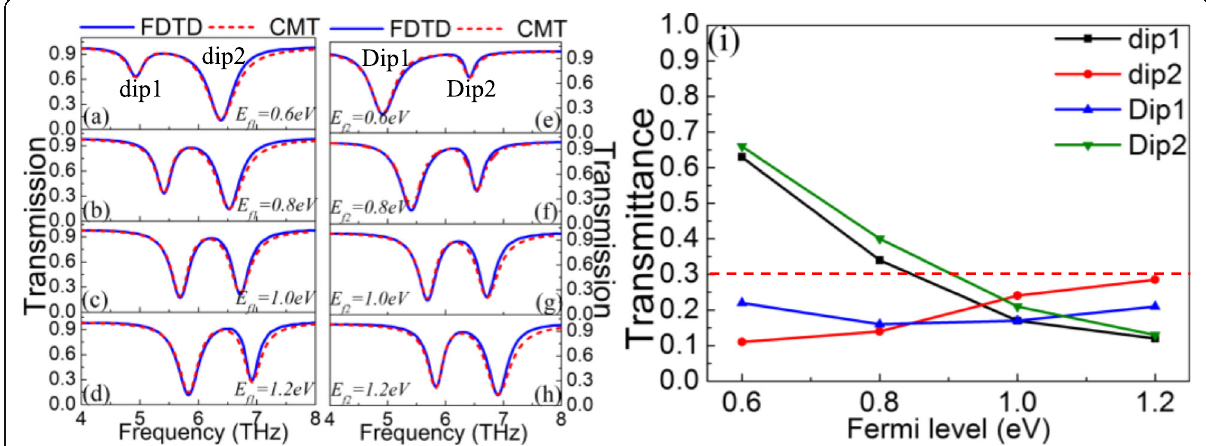
Fig. 3 Transmission spectra of FDTD simulation and CMT fitting ( a – d ) for different E f 1 when E f 2 = 1.0 eV. e – h For different E f 2 when E f 1 = 1.0 eV. i Relationship between the transmittance of resonance dip and the Fermi